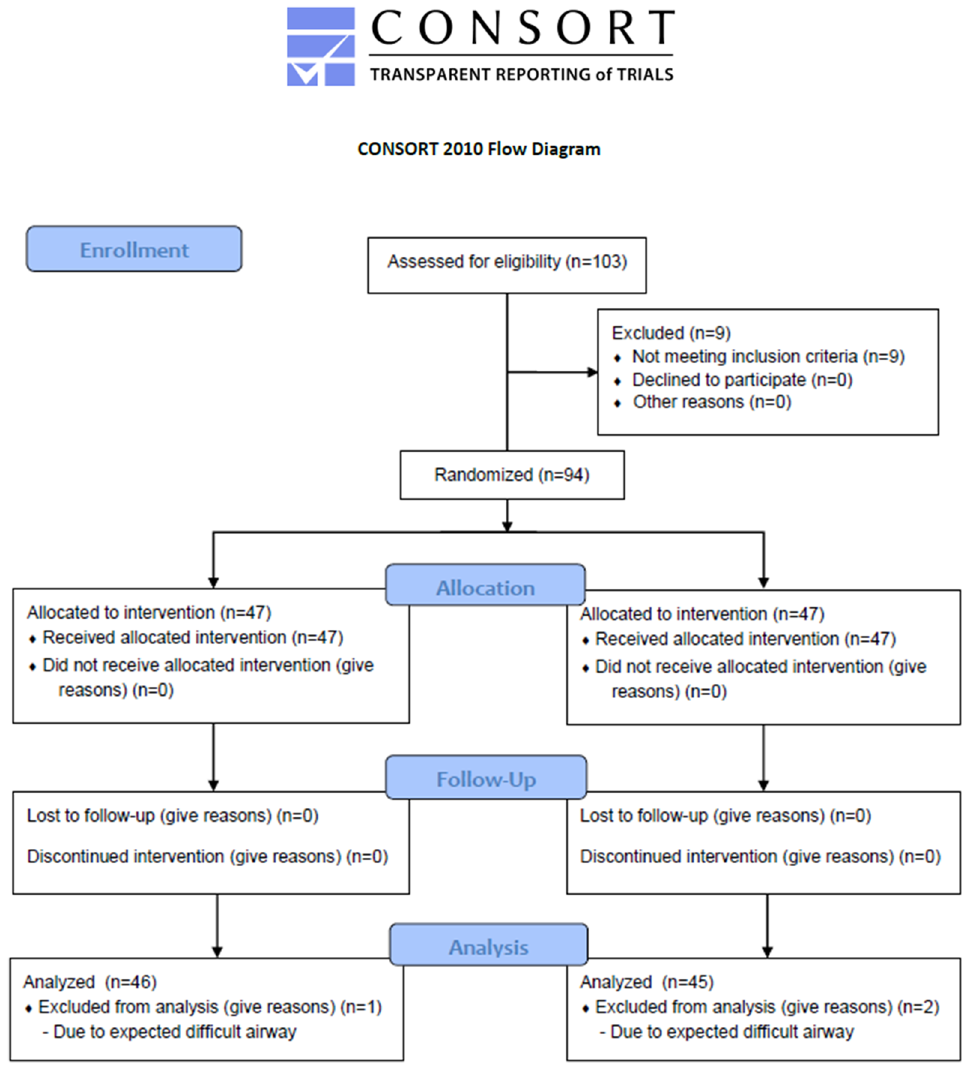
Figure 1. The CONSORT flow